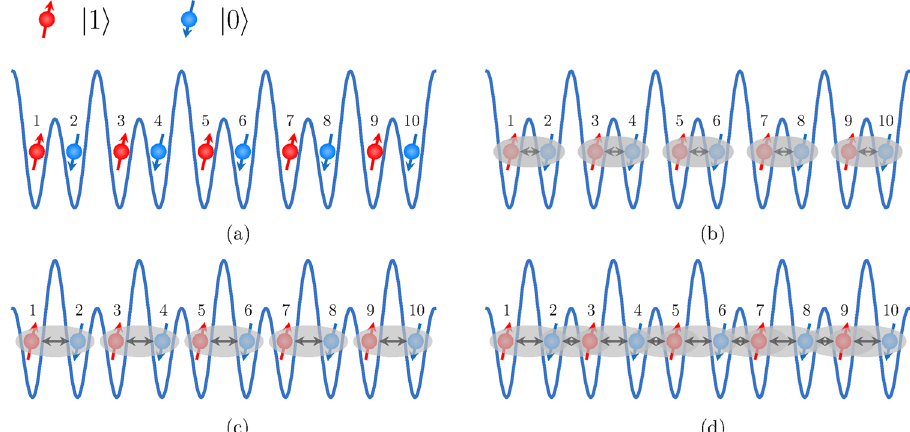
Fig. 2 Illustration of the preparation protocol. a Generate Néel state with selective spin- fl ip. b Entangle and prepare the atom pairs into Bell ffiffiffiffiffiffiffiffiffiffiffiffi p y SWAP gate. c Shift the position of double wells by changing the relative phase ϕ . d Entangle the neighbour atoms which are not state with entangled in b